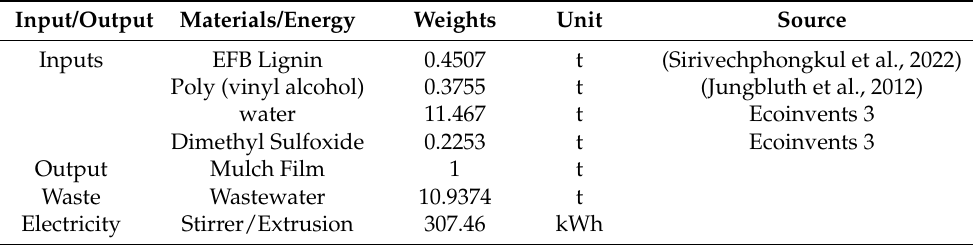
Table 1. Life Cycle Inventory of mulch film with PVA and